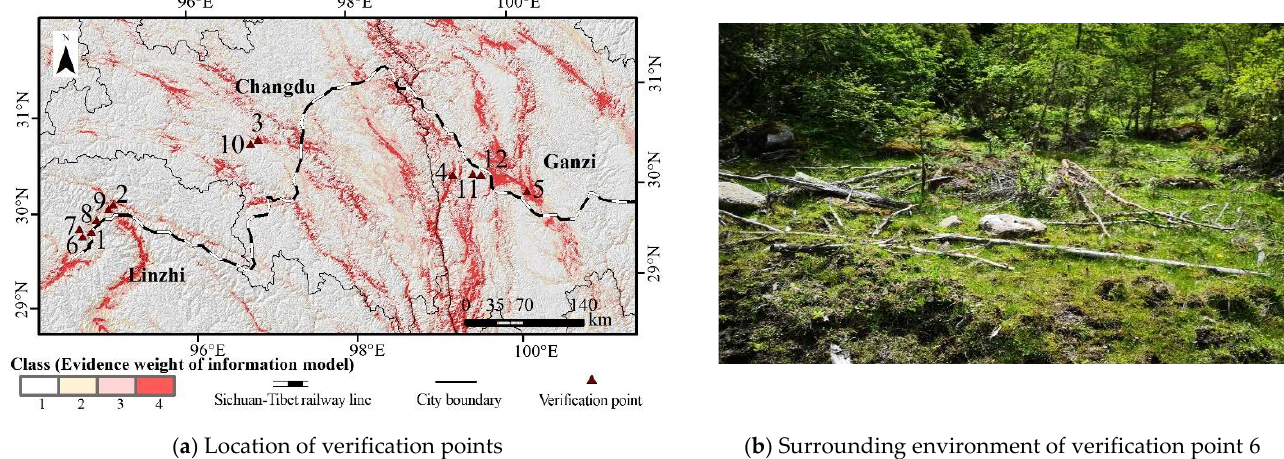
Figure 8. Curves of prediction ratio function and its area ratio.